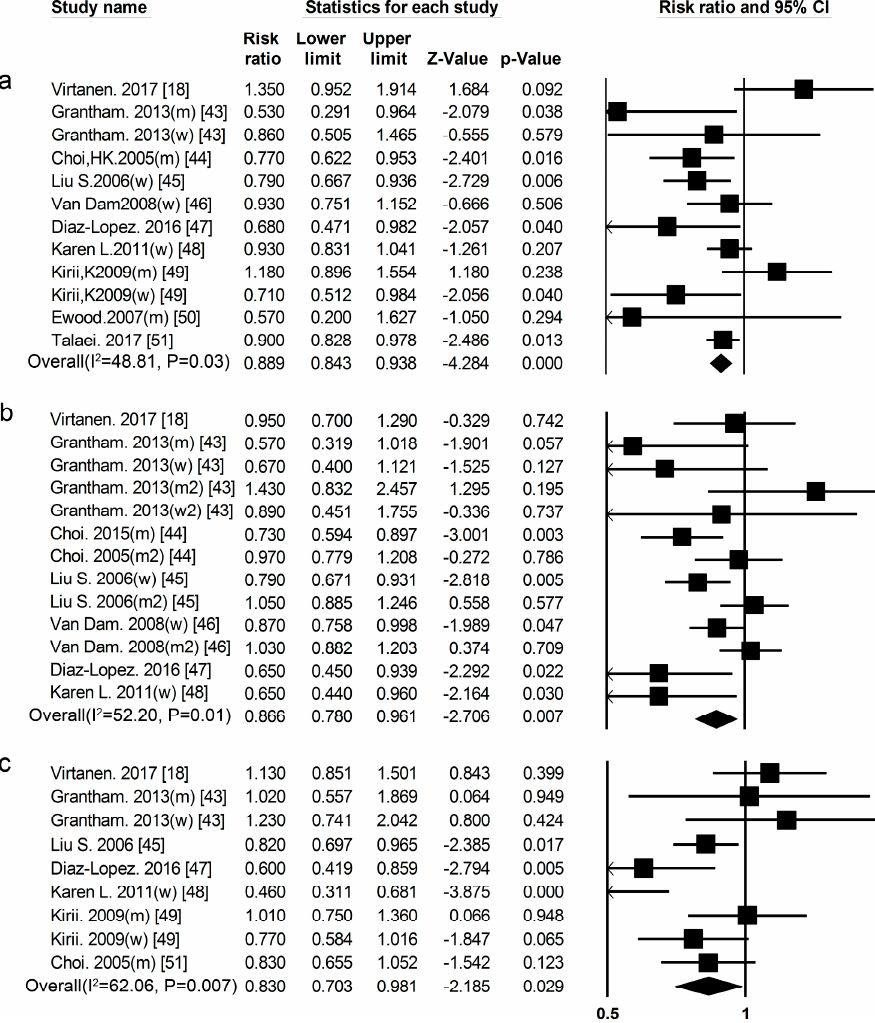
Figure 8. ( a ) Total dairy products ( b ) whole milk ( c ) yogurt and type 2 diabetes RRs for the highest vs. the lowest intake in all subjects. The RR of each study is represented by a square, 95% CI are represented by the horizontal lines, and the diamond represents the estimate and its 95% CI.